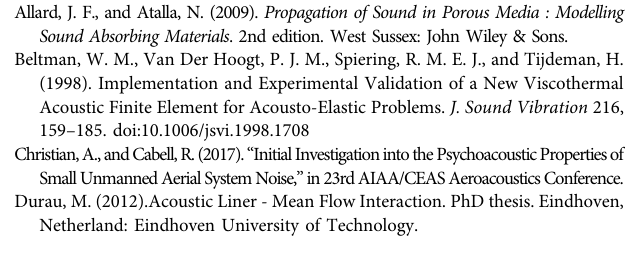
Frontiers in Materials |